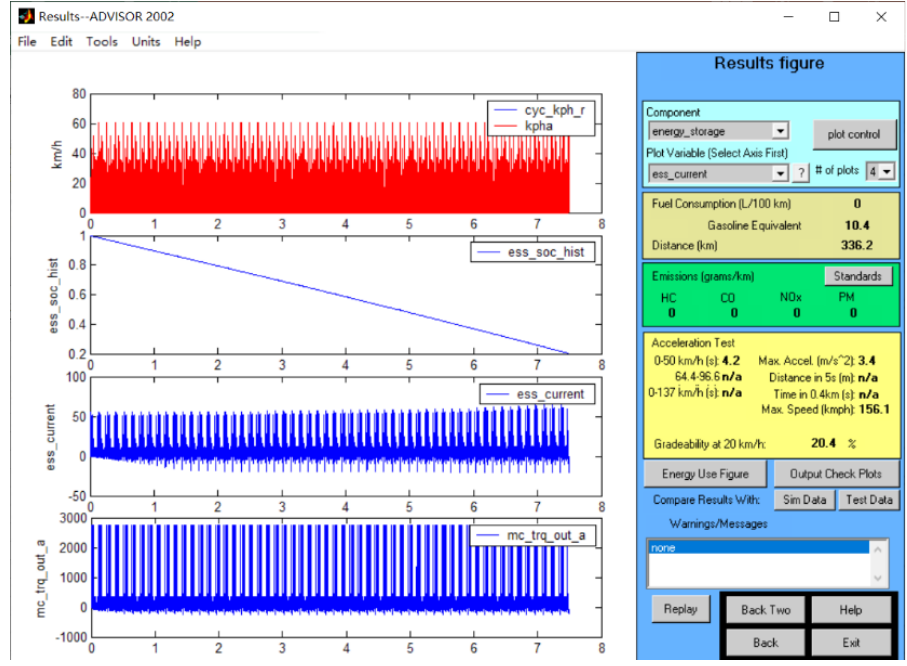
Figure 17. Simulation results of experiment 9.